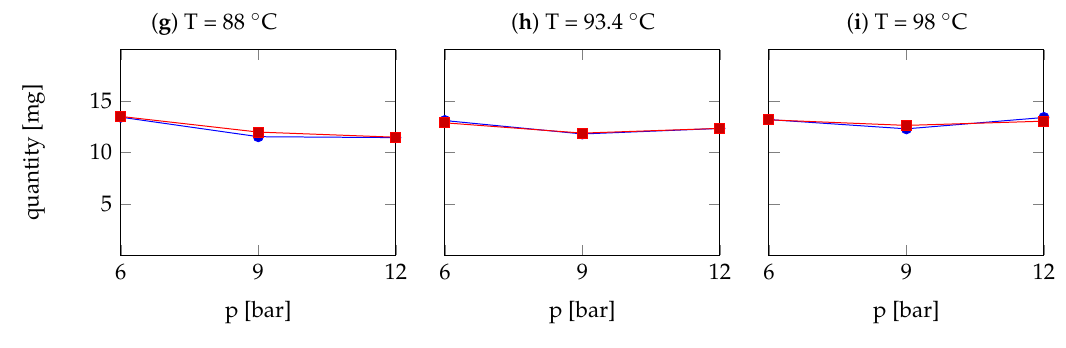
Figure 9. Comparison between the ferulic acid extracted through numerical simulations (blue profile with circles) and laboratory measurements (red profile with squares), with different inlet water tempera- tures and pressures and different grain size of Arabica coffee powder. Figures ( a – c ) show the results of optimal granulometry, Figures ( d – f ) of coarse granulometry and Figures ( g – i ) of fine granulometry.